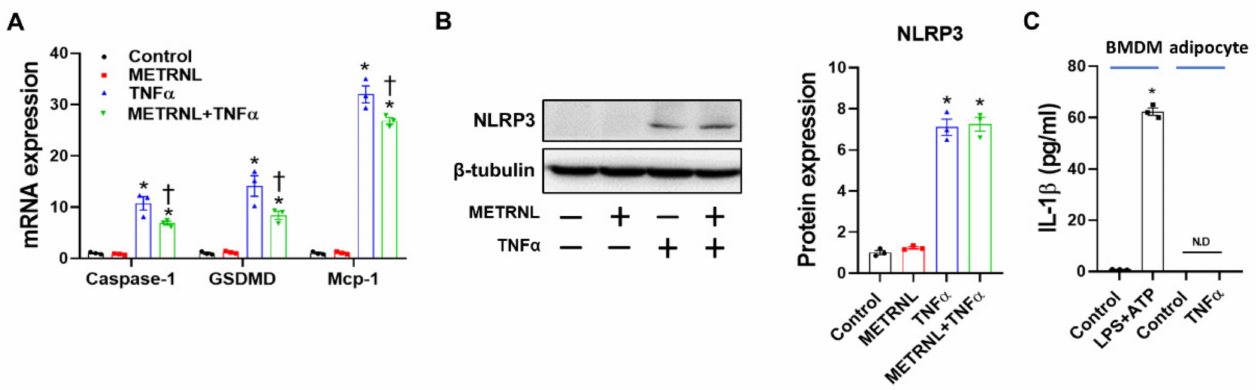
Figure 7. METRNL inhibits gene expression but not protein expression of NLRP3 inflammasome in 3T3-L1 adipocytes. ( A ) Mature 3T3-L1 adipocytes were pretreated with METRNL (100 ng/mL) for 1 h, followed by treatment with TNF- α (10 ng/mL) for 24 h. Gene expression levels were measured via real-time PCR. The quantifications were normalized to the 18S rRNA level for each target. ( B ) Representative Western blots and quantification of NLRP3 in mature adipocytes. ( C ) Mature adipocytes were treated with TNF- α (10 ng/mL) for 24 h, and IL-1 β levels in supernatant were measured using ELISA. BMDMs treated with LPS+ATP for 6 h are shown as a positive control. Values are presented as mean ± SEM. * p < 0.05 compared with control, † p < 0.05 compared with TNF- α